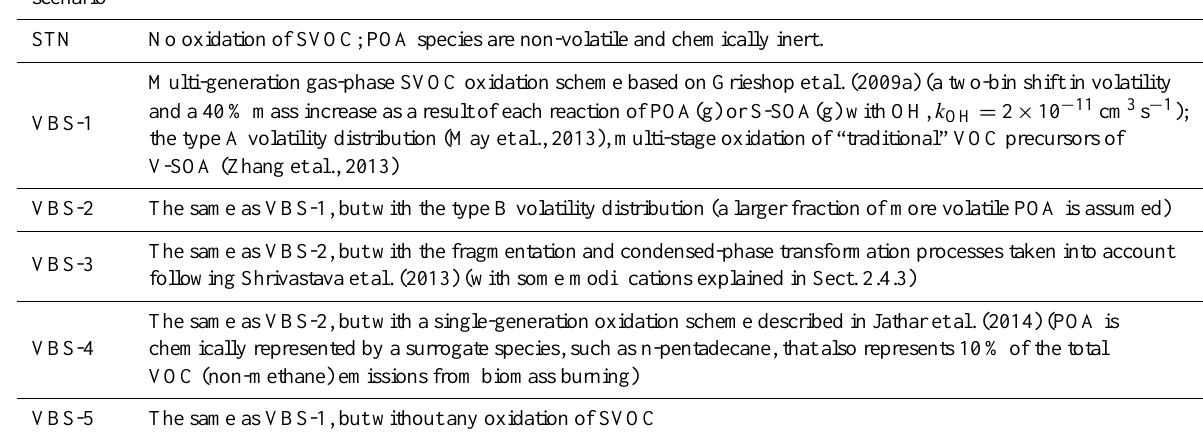
Table 3. Simulation settings for the different modeling scenarios with emissions from fires. The corresponding two types (A and B) of volatil- ity distributions are specified in Table 1. Note that along with the simulations based on the “fire” scenarios listed in the table, an additional model run (“BGR”) was made to simulate “background” conditions in the absence of fire emissions (see Sect. 2.8). SVOC: semi-volatile organic compounds; VOC: volatile organic compounds; POA: primary organic aerosol species; S-SOA: SVOC produced from oxidation of POA; V-SOA: SVOC produced from oxidation of